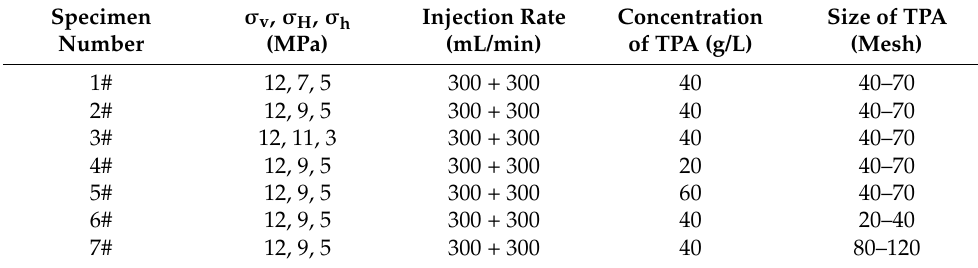
Table 1. Experimental scheme.